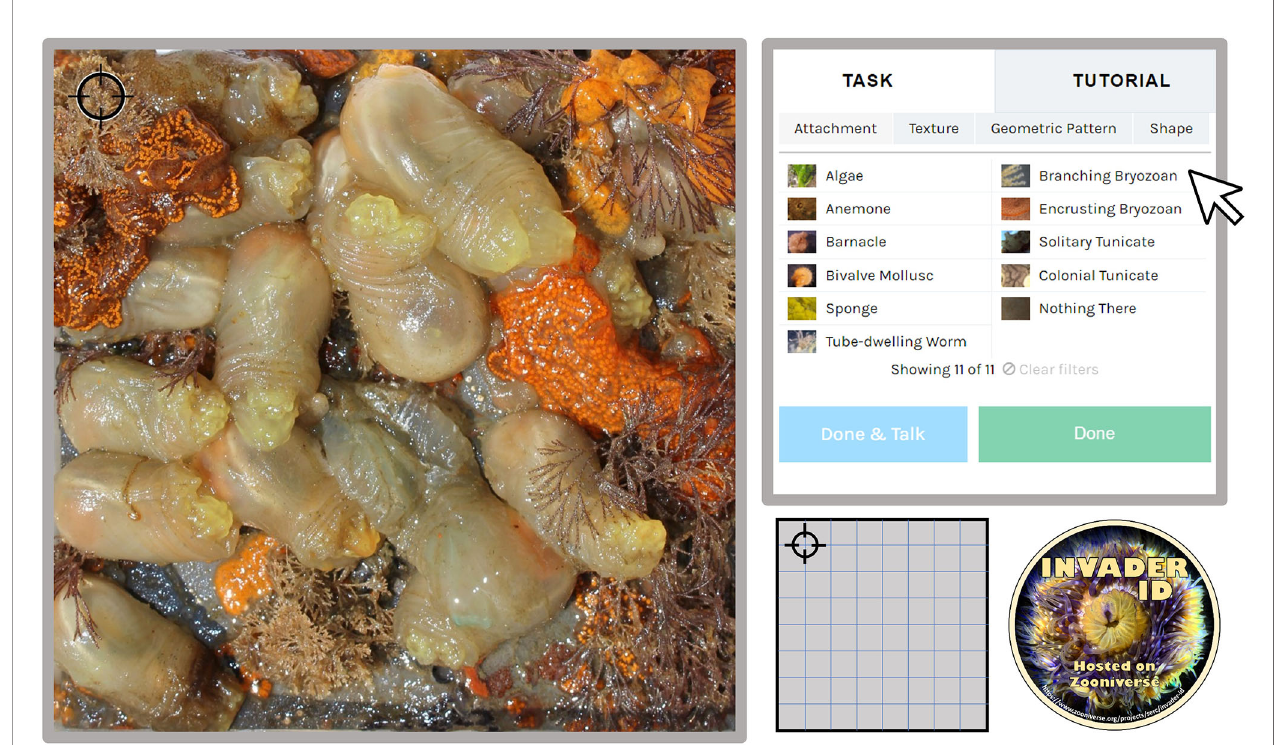
FIGURE 1 | Example work fl ow of Invader ID from the online Zooniverse portal. Volunteers identify the taxa in the center of the black target (upper left of panel) using the information provided from the identi fi cation key (top right). This panel will appear in 49 other iterations with the target moved along a 7x7 grid (see example in bottom center of Figure) and one randomly placed location to create a 50-point count. Photo credit to the Smithsonian Environmental Research Center, Marine Invasions Lab Fouling